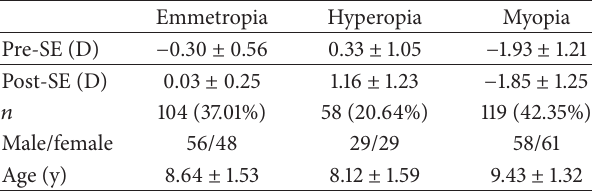
Table 1: Patient demographics and refractive